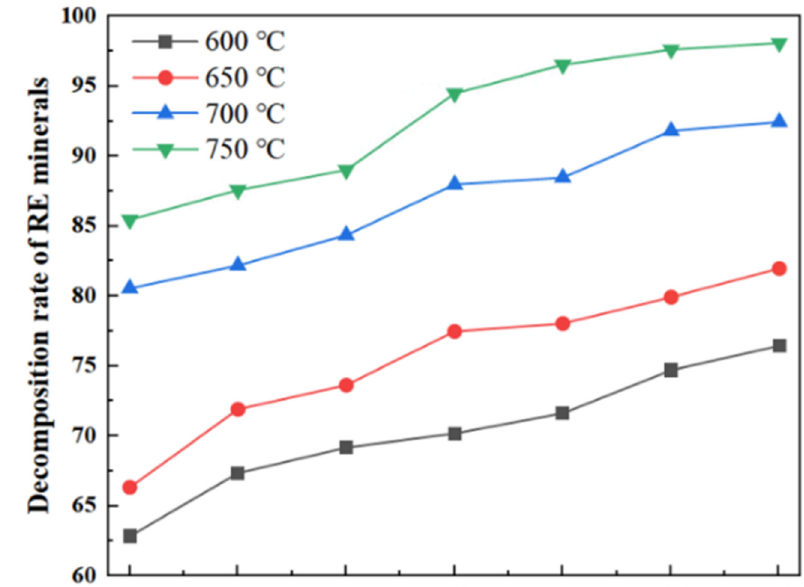
The effects of roasting temperature and holding time on the decomposition rate of RE minerals were investigated with a constant MgO mass ratio of 10 wt.%. The holding time for roasting varied in the range of 0–120 min. The results are presented in Figure 8, showing that the decomposition rate increased with the temperature and holding time, respectively.